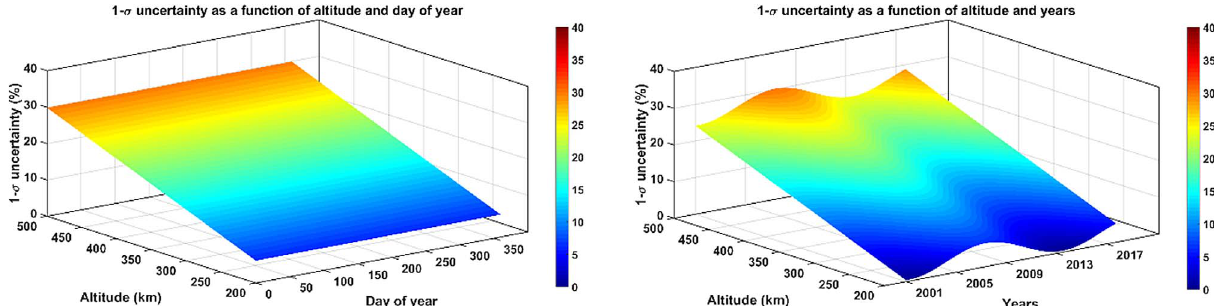
Fig. 7. 3D plot of the 1- r uncertainty (in percent) as a function of altitude and time evolution: (left) day of the year (right) years.